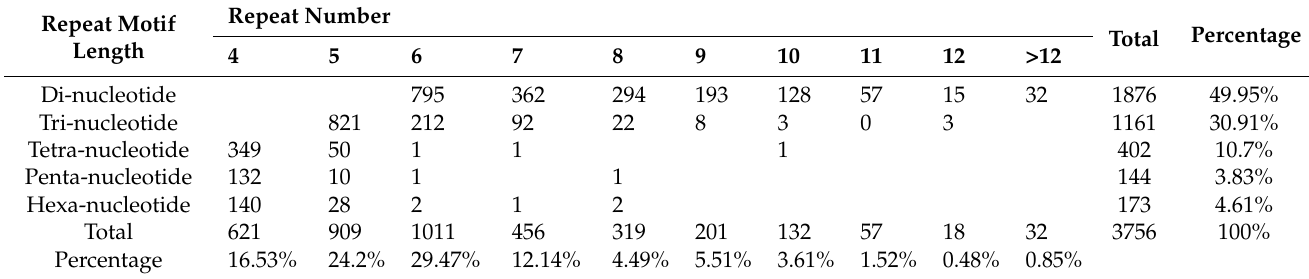
Figure 6. Fluorescence in situ hybridization of PtRab in P. tabuliformis ovules. ( A – C ) The spatiotempo- ral expression of PtRab in ovules from FNM1 to FNM3 period in fertile line. ( D – F ) The spatiotemporal expression of PtRab in ovules from FNM1 to FNM3 period in sterile line. FG: female gametophyte, FN: free nucleus, I: integument. Table 1. Occurrencefrequencyofdifferentmicrosatelliterepeatmotifsof P.tabuliformis